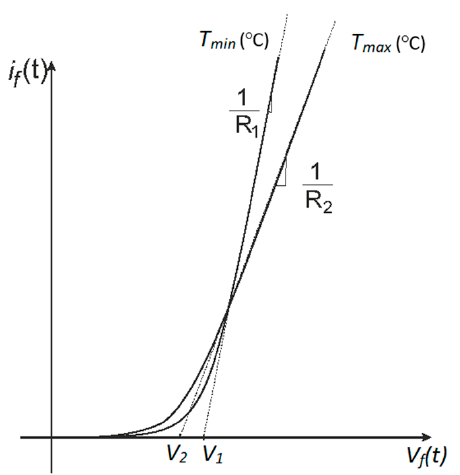
Figure 6. Typical diode forward characteristics and first order (linear) approximation.